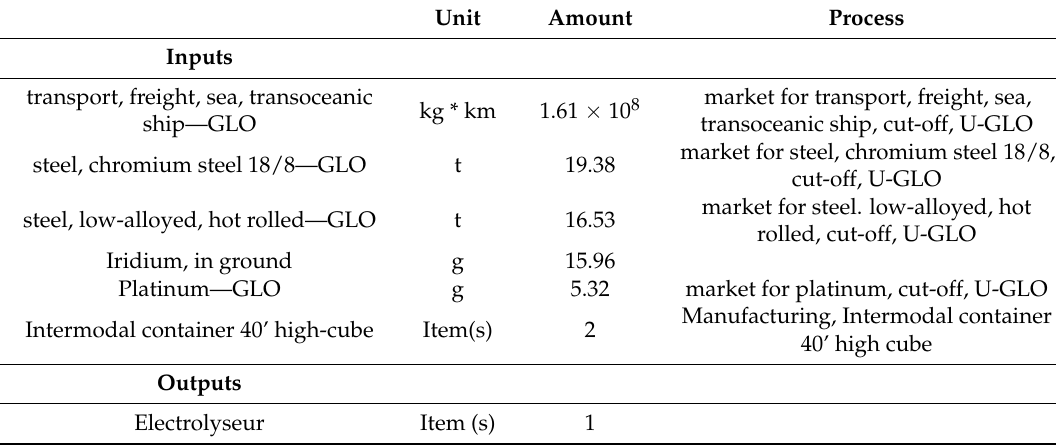
Table A9. Manufacturing,